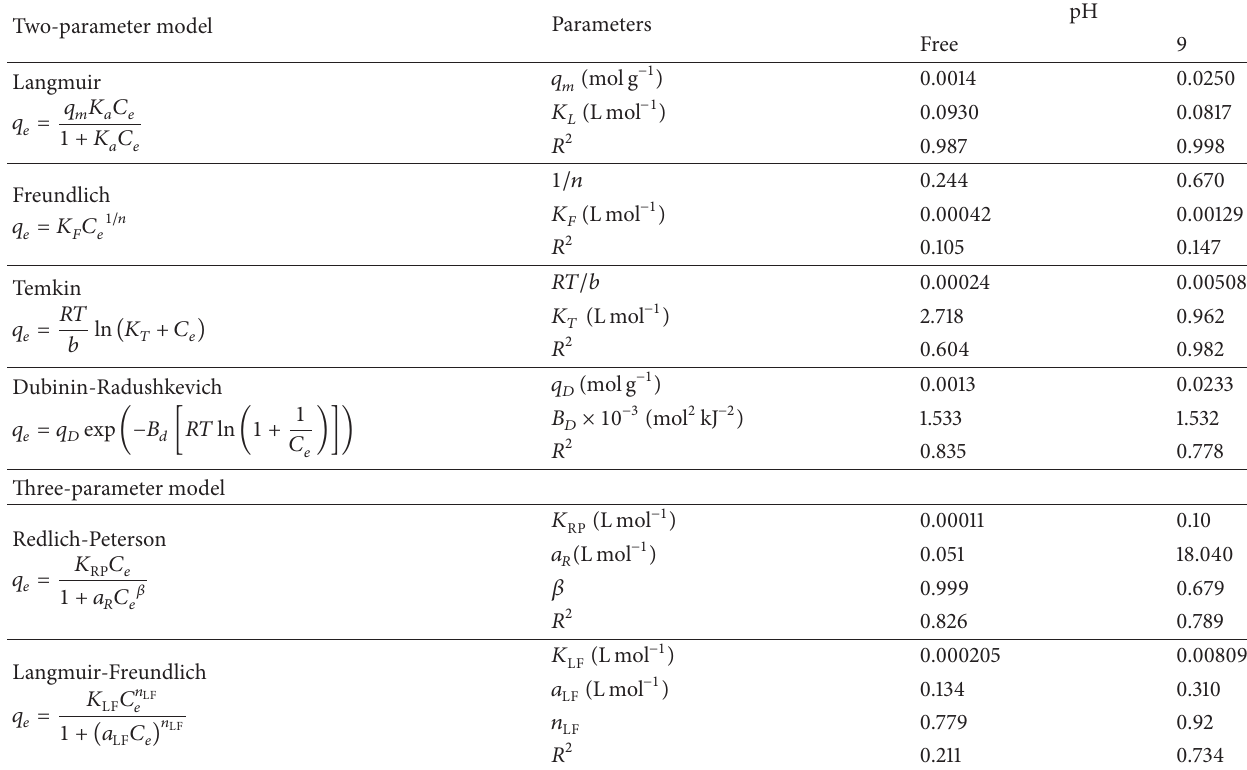
obtained by linear method at 25 ∘ C. 2